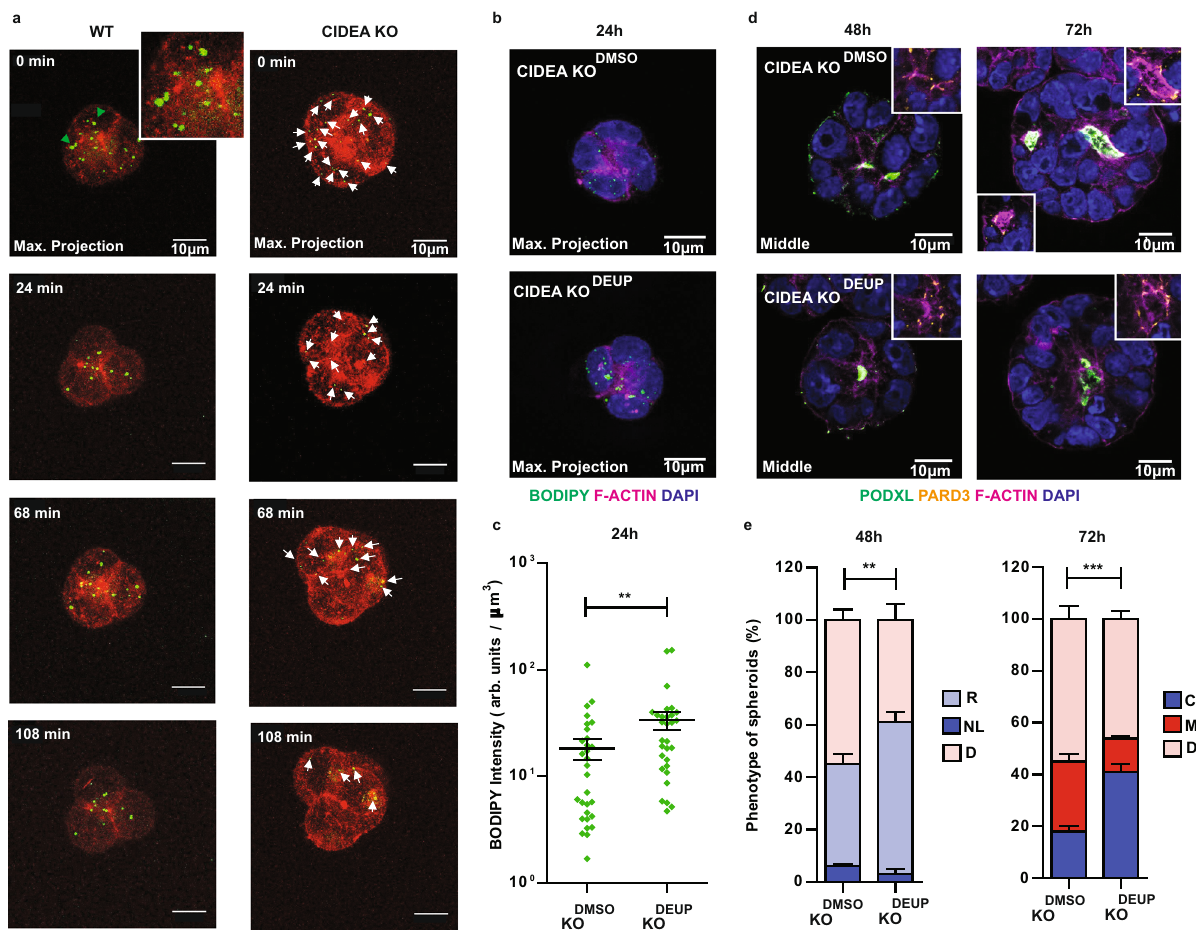
Fig. 4 CIDEA-mediated LD enlargement confers protection against promiscuous degradation by cytosolic lipases. a Time-lapse live imaging of BODIPY 493/503 pulse-labelled LDs in spheroids formed by LifeACT-RFP-expressing WT and CIDEA KO ESCs 24 h post-induction of differentiation (see also Supplementary Movies 4 – 6). White arrows indicate small LDs being degraded in CIDEA KO spheroids. Representative images of ~9 spheroids across independent experiments ( n = 7). b Representative images of BODIPY-stained LDs in CIDEA KO spheroids treated with DMSO (CIDEA KO DMSO ) and the cytosolic lipase inhibitor DEUP (CIDEA KO DEUP ) for 24 h upon induction of differentiation ( n = 3). DEUP, Diethylumbelliferyl phosphate. c Quanti fi cation of neutral lipid content (BODIPY fl uorescence intensity normalised to spheroid volume) in spheroids from ( b ). n = 30 spheroids per condition and time-point. Error bars, means± s.e.m. ( n = 3); two-sided Mann – Whitney U test, ** p < 0.01 ( p = 0.0053). d Representative images of CIDEA KO DMSO and CIDEA KO DEUP spheroids at indicated time-points. Foci of lumen formation are marked by PODXL, PARD3 and F-ACTIN ( n = 3). e Quanti fi cation of the phenotype of spheroids from ( d ). n (cid:1) 168 spheroids; error bars, means ± s.e.m. ( n = 3); two-sided Chi-square (Fisher exact) test, ** p < 0.01 (48 h, p = 0.0016); *** p < 0.001 (72 h, p = 8 × 10 − 7 ). R, rosette; NL, nascent lumen; CL, central-lumened; ML, multi-lumened; D, disorganised. Source data are provided as a Source data fi